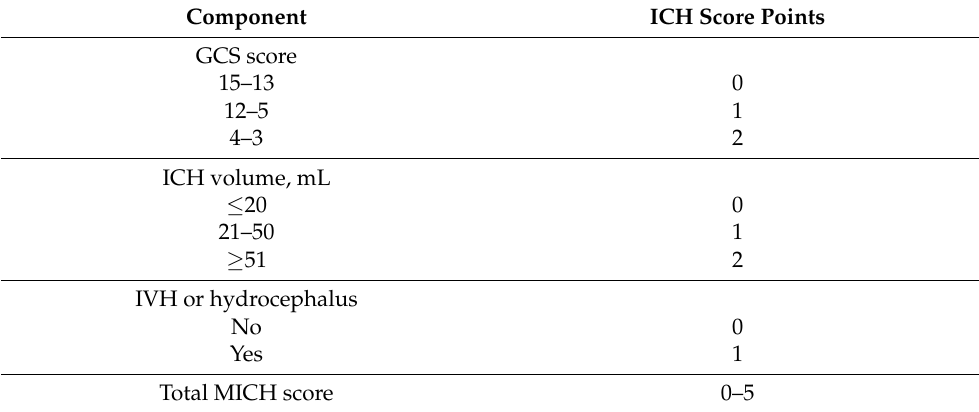
Table 1. A new modified intracerebral hemorrhage (MICH)